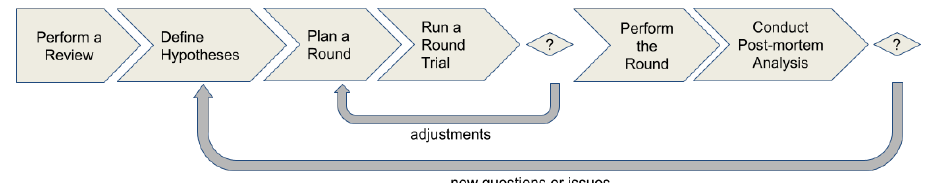
Figure 2. Research